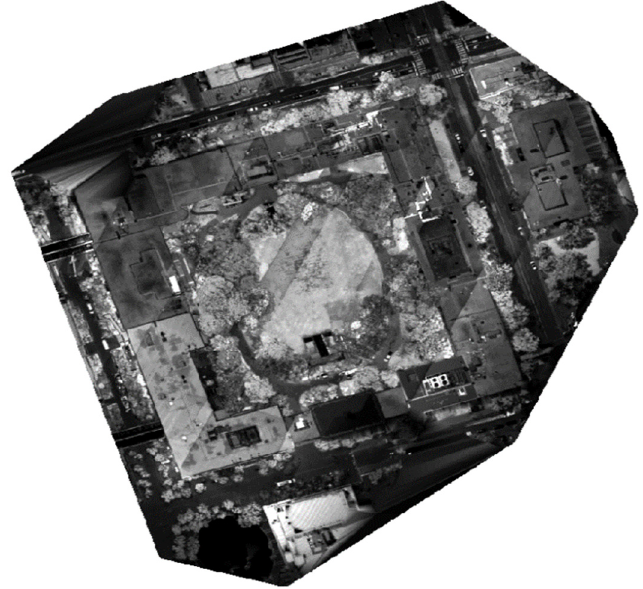
Figure 17. Intensity raster generated using the solid-state LiDAR data point cloud for the second test site.